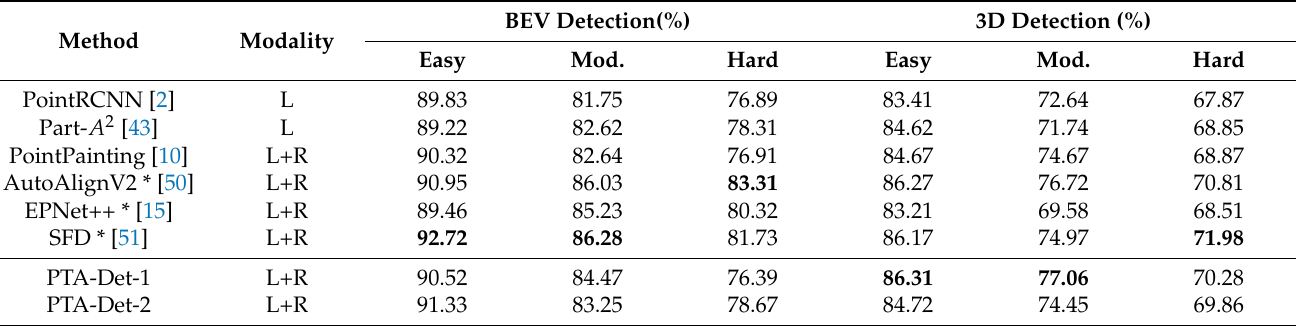
Table 3. Performance comparisons on the KITTI validation set. All methods adopt the same fore- ground point sampling strategy proposed in Pseudo Point Generation Network, and they do not use any data augmentation technique for a fair comparison. All results are reported by the average preci- sion with 0.7 IoU threshold and 40 recall positions for car category. * indicates our re-implementation. The optimal results are highlighted in bold